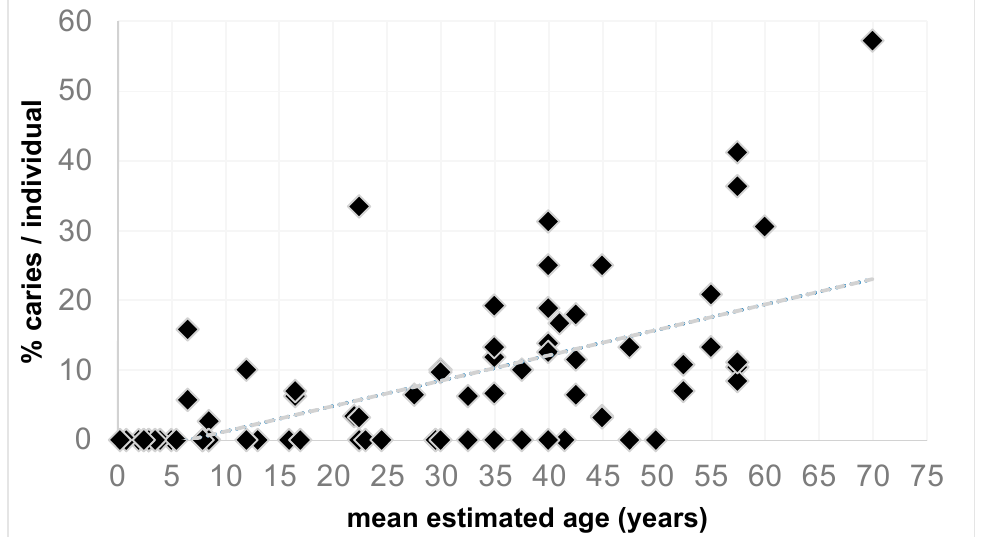
Figure 2. Scatterplot showing the significant relationship between the mean estimates of age in years and the percentage of caries per individual.